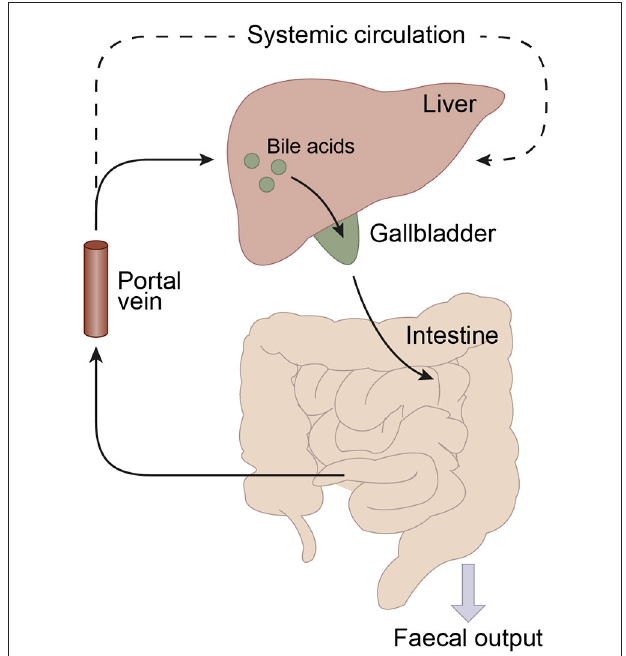
FIGURE 2 | Schematic representation of the enterohepatic circulation of bile acids. Bile acids are synthesized in the liver and stored in the gallbladder. Following food intake, bile acids are released into the duodenum. Traveling down the intestine, the majority of bile acids are taken up by enterocytes. In the jejunum and colon passive diffusion of unconjugated and uncharged bile acids takes place and the ileum is the main site for active uptake of conjugated bile acids by bile salt transporters. About 95% of the bile acids are reabsorbed in the ileum and consequently only a small portion ( ∼ 5%) of the bile acids is lost through fecal output. The bile acids that are absorbed by the enterocytes are released into the portal vein and redirected to the liver for recycling. Only a small portion escapes the enterohepatic circulation and reaches the systemic circulation. The liver extracts 80–90% of the portal total bile